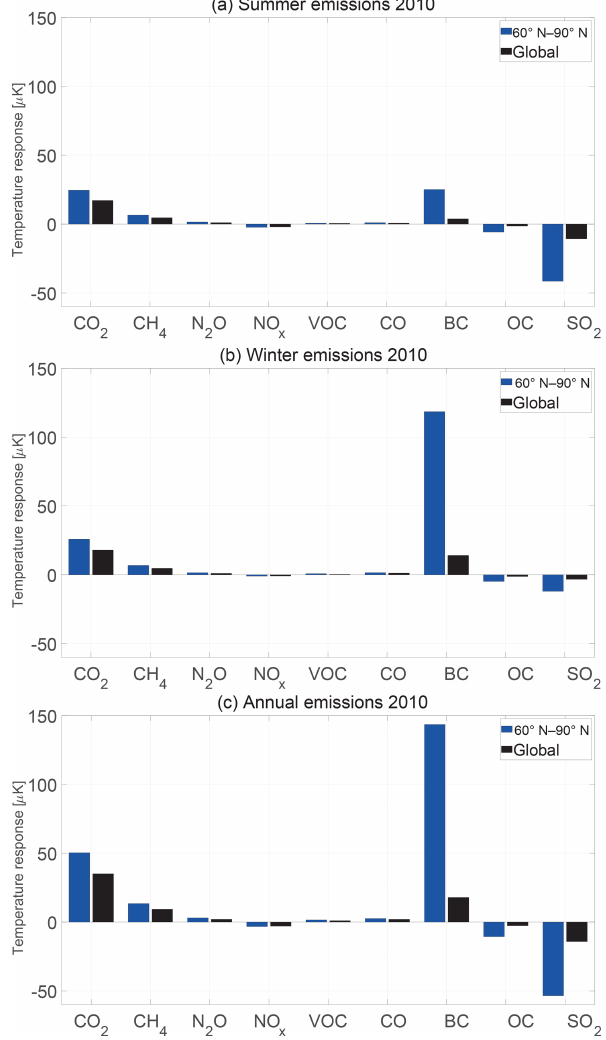
Figure 8. Global and Arctic (60–90 ◦ N) temperature responses (µK) to Finnish emissions based on ARTP values in Aamaas et al. (2017) and Sand et al. (2016). As for most of the figures, the temperature response is the mean response 1 to 25 years after a pulse